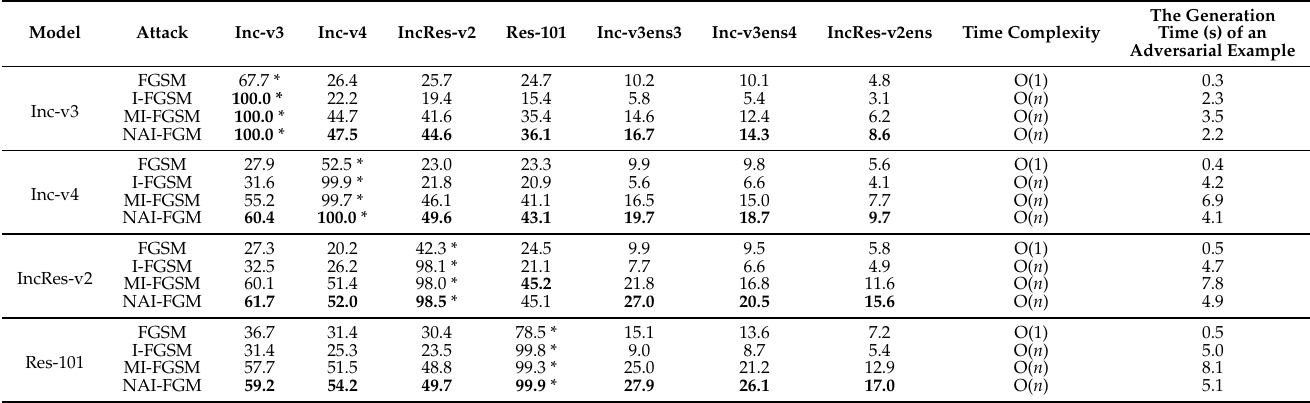
Table 3. The success rates (%) of NAI-FGM compared to advanced gradient-based attacks when attacking a single model. * indicates the white-box